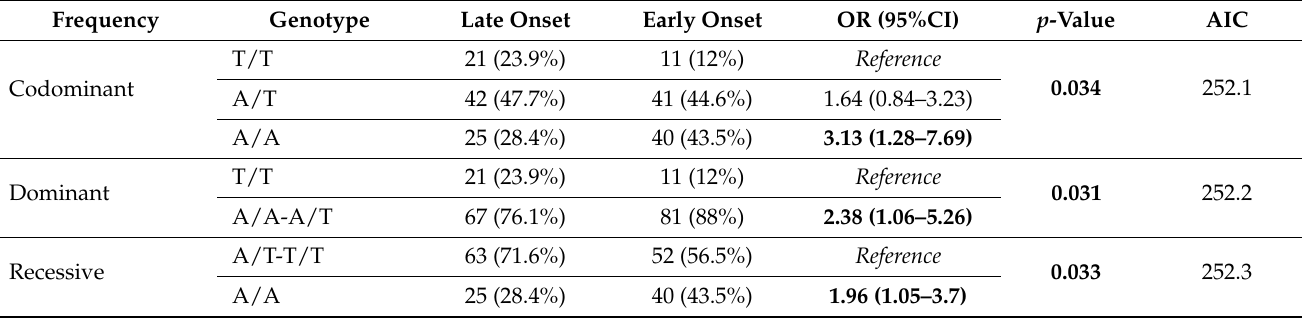
Table 3. Genetic inheritance association models for the LINC-ROR gene variant and early cancer risk.